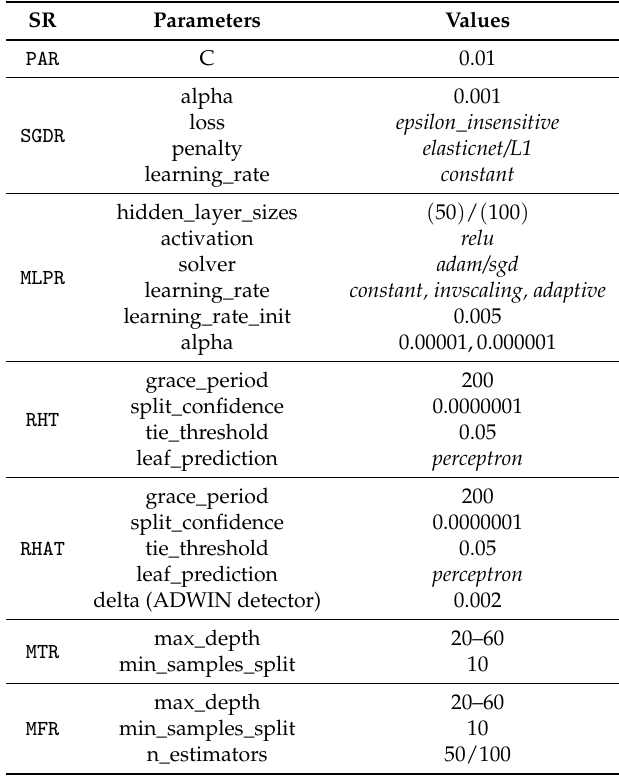
Table 10. Hyper-parameter tuning results for SRs in the experiment 3.